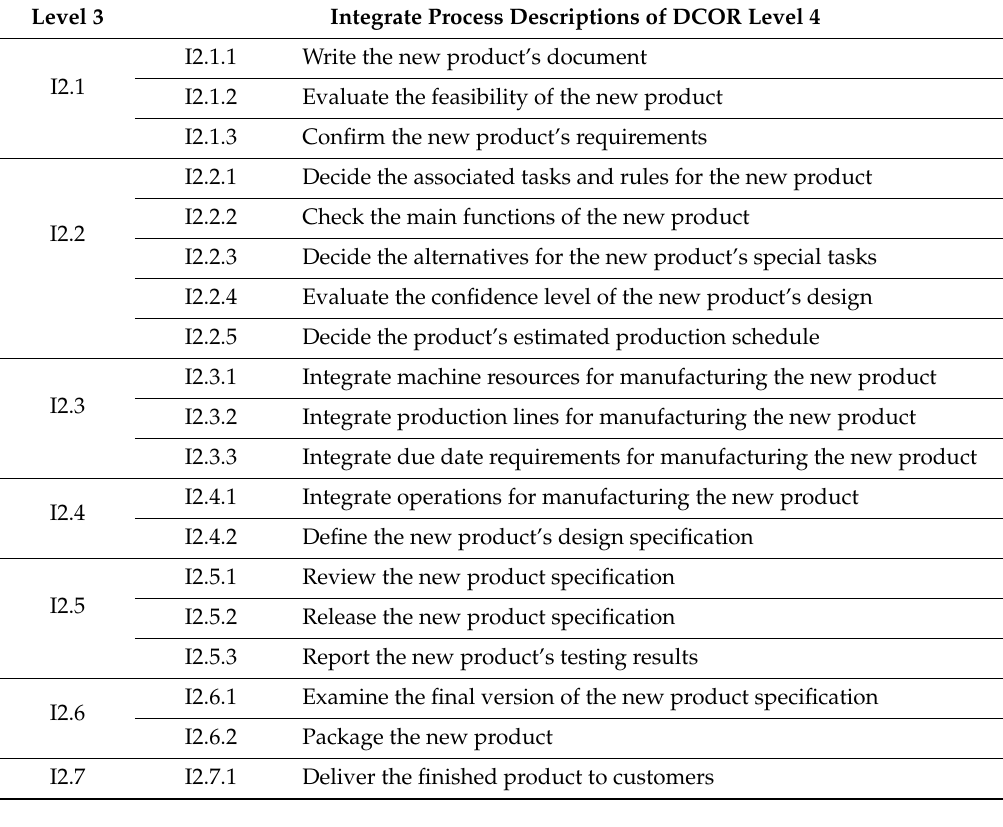
Table 4. Integrate process of DCOR Level 4.